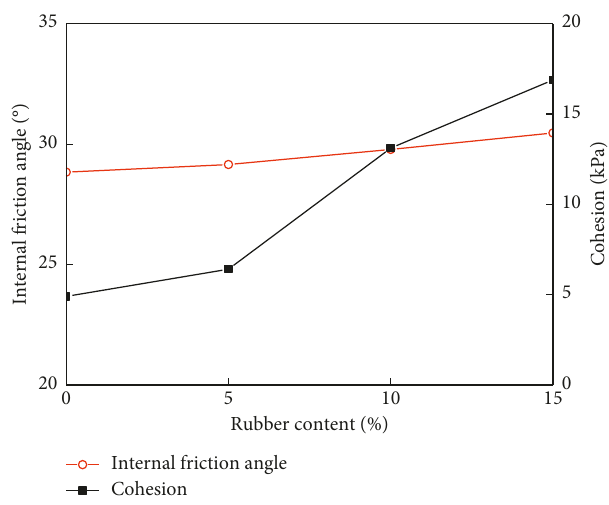
Figure 7: Relationship between internal friction angle, cohesion, and rubber